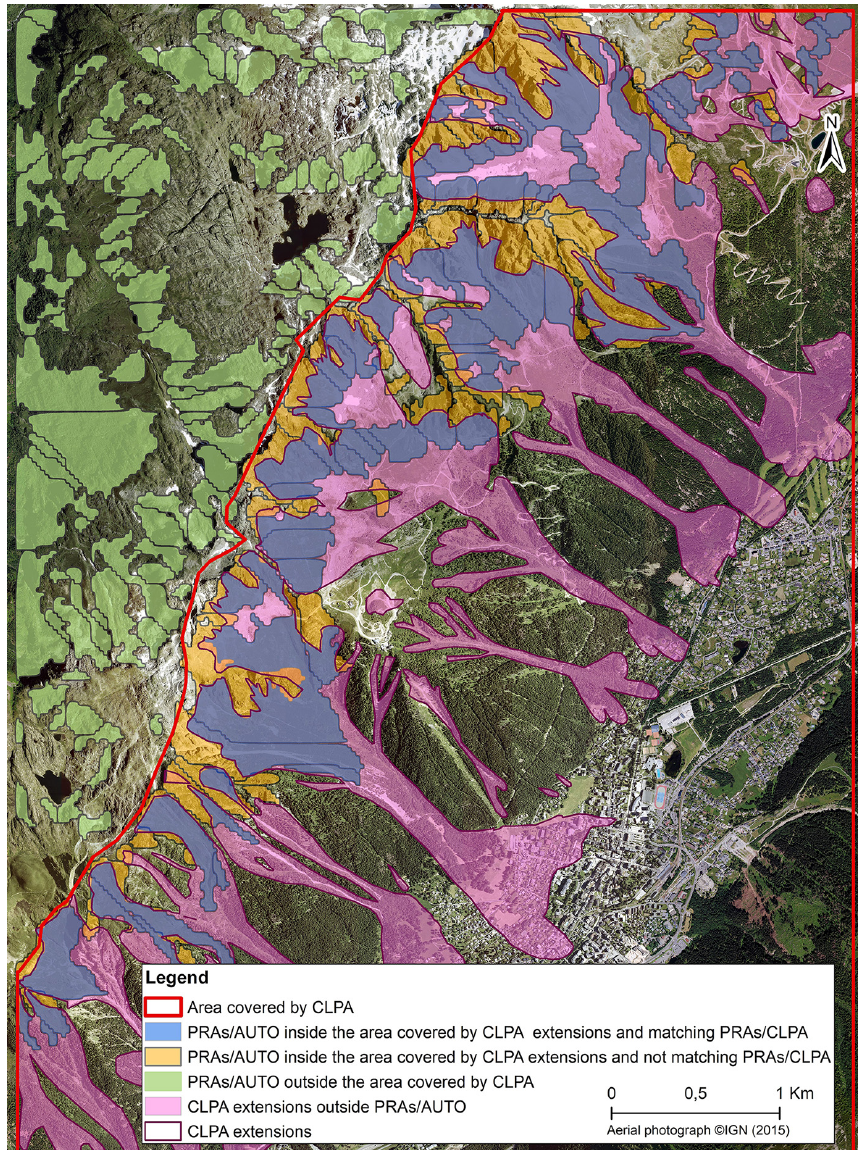
Figure 5. Result of the proposed PRA detection method for the study area of Chamonix. Agreement and mismatches with the avalanche ex- tents from the French avalanche cadastre (“CLPA extensions”) are highlighted. For the PRA detection and the determination of the validation sample, all factors and the DEM resolution are set to their default values (Figs. 3–4), and forest cover data are from DB forest